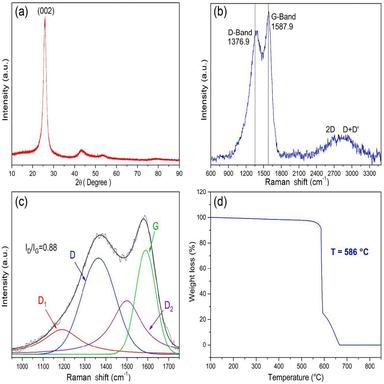
Structural and thermal characterizations of NP-CNTSs. (a) XRD pattern showing the (002) crystallographic planes, typical of graphitic materials. (b) Raman spectrum showing graphitic materials' D, G, 2D, and D + G bands. The vertical lines refer to the vibration modes from graphite. (c) Deconvolution analysis of the D- and G-band using two Gaussian and two Lorentzian curves (D1, D, D2, and G). (d) TGA curve showing the thermal stability of NP-CNTSs. The oxidation temperature corresponds to 753